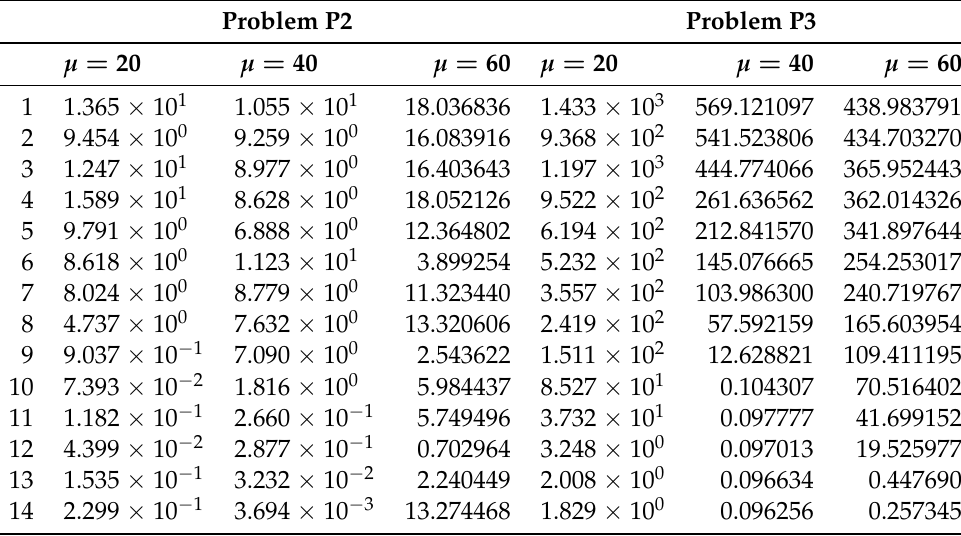
Figure 3. On problem P2 with a spherical constraint, we depict for three sizes of the approximation set ( µ 20,40,60 ; from top to bottom ), the final approximation set ( left column ; green stars), the ∈ { } corresponding objective points ( middle column ; green stars), and the evolution of the HV value and G ( X , λ ) ( right column ). The initial points are sampled uniformly at random in the convex hull of (cid:107) (cid:107) three points ( 1,1,0 ) (cid:62) , ( 1, 1,0 ) (cid:62) , and ( 1,0,0 ) (cid:62) . − − G ( X , λ ) Table 2. The evolution of on problems P2 and P3. (cid:107) (cid:107) Problem P2 Problem